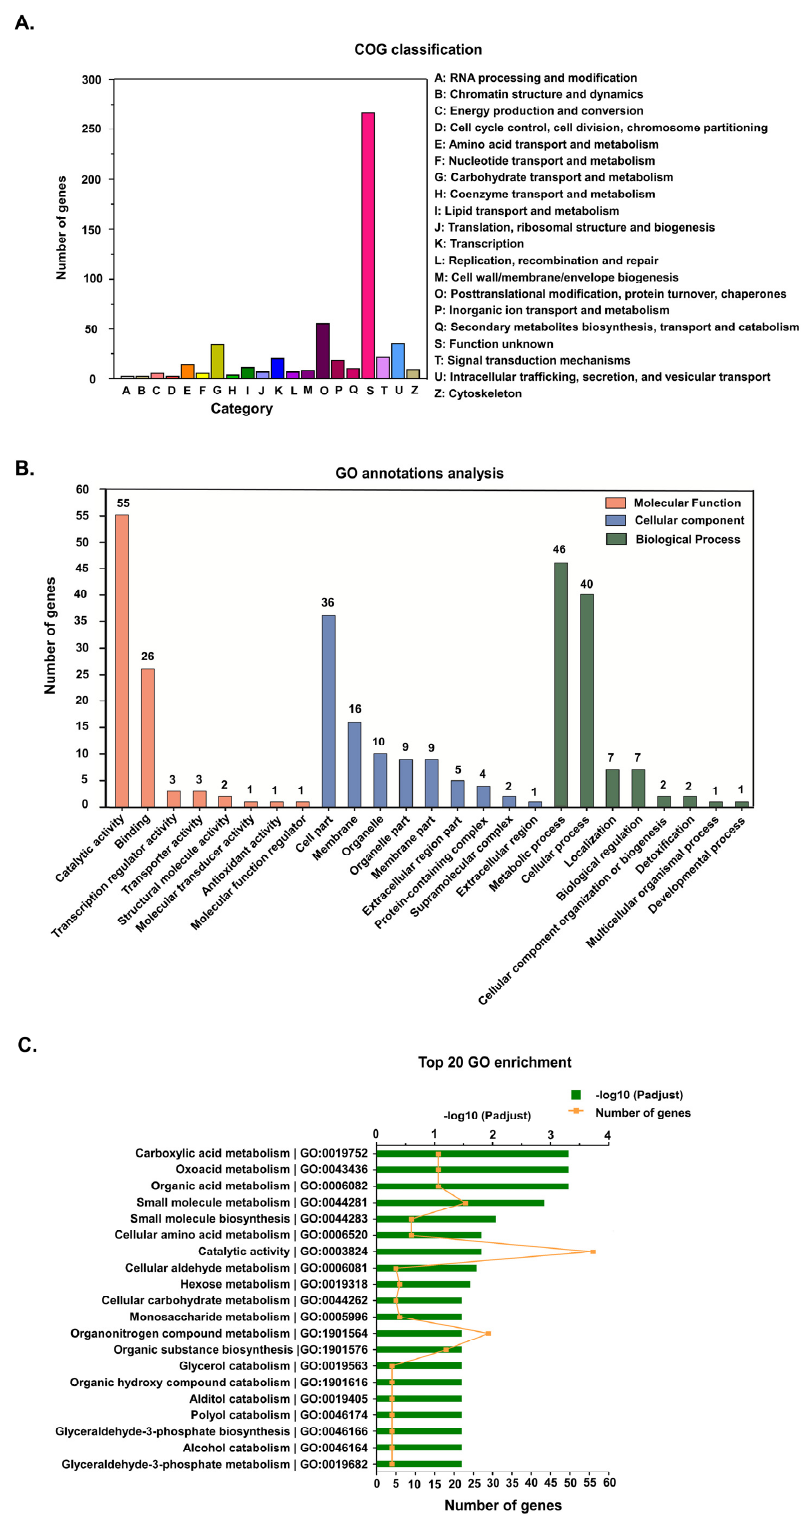
Figure 2. Annotation of differentially expressed genes (DEGs). ( A ) Cluster of orthologous groups (COG) classification of the putative proteins encoded by the DEGs. ( B ) Gene ontology (GO) annota- tions of DEGs. Genes were categorized into three categories: biological process, cellular component and molecular function. ( C ) The top 20 GO enriched